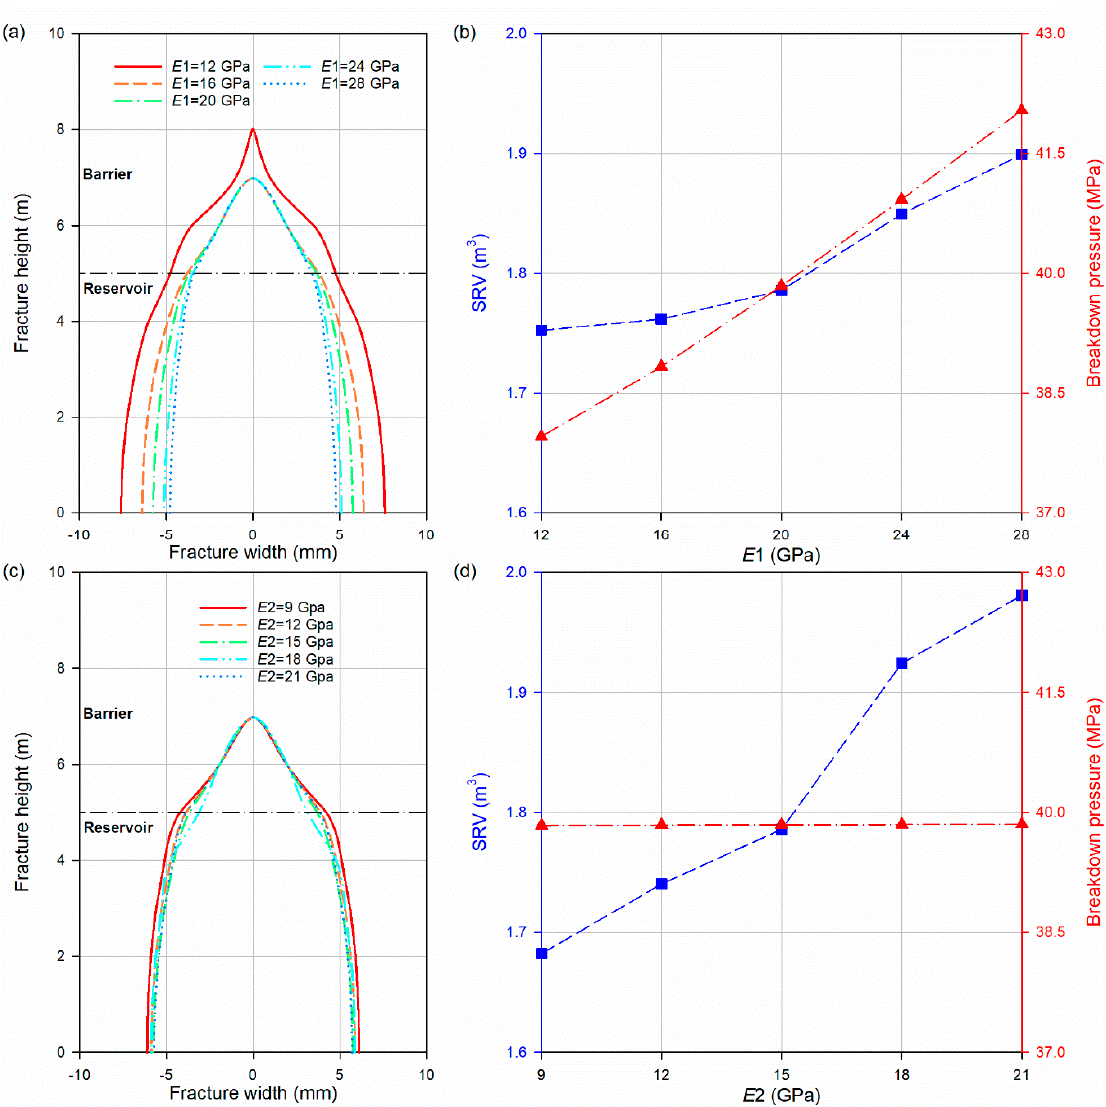
Figure 12. Fracture morphology, SRV, and breakdown pressure under different Young’s modulus. ( a ) Profiles of fractures under different reservoir Young’s modulus E 1; ( b ) SRV and breakdown pressure under different E 1; ( c ) profiles of fracture under different barrier Young’s modulus E 2; ( d ) SRV and breakdown pressure under different E 2.